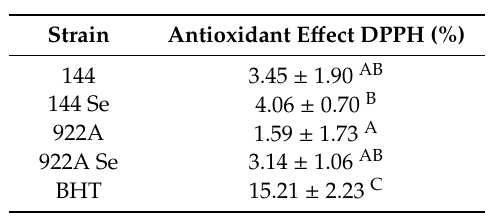
Table 2. Antioxidant capacity (%) of the strains CCDM 144 and CCDM 922A before and after selenium-enrichment using the 2, 2-diphenyl-1-picrylhydrazyl (DPPH) method.